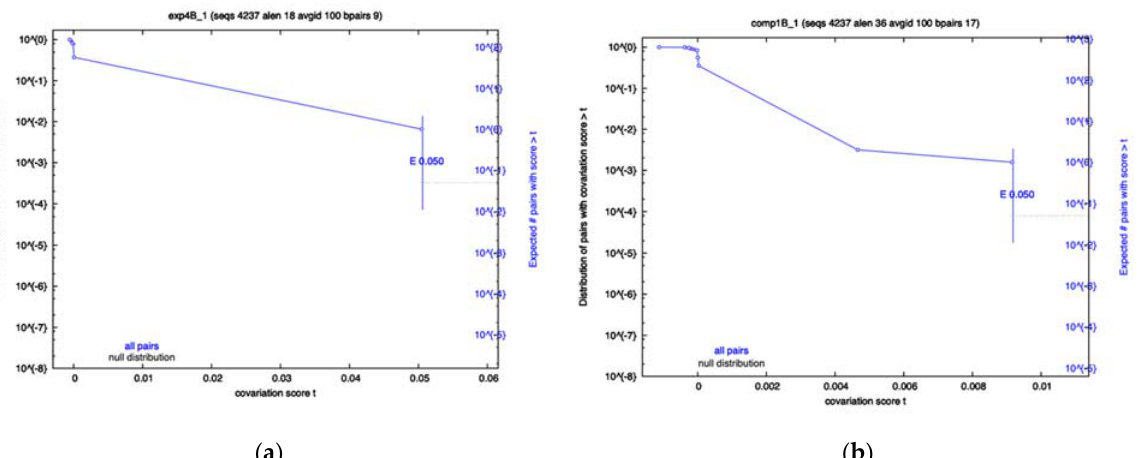
Figure 2. Survival plots from the variant-specific covariation analysis. Displayed are the most significant results. Beta showed significant covariation for Exp4 panel ( a ) and Comp1 panel ( b ). Significance cutoff E-value used was 0.05.